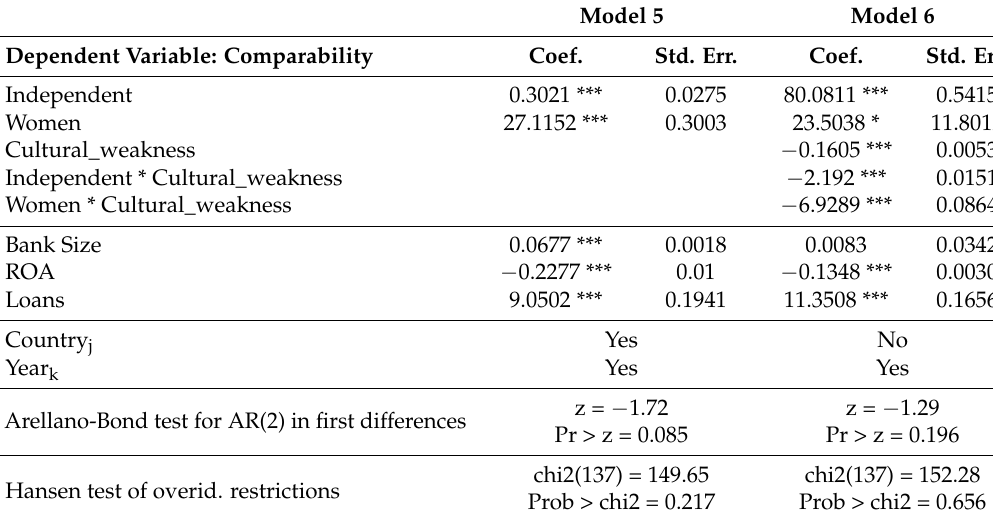
Table 8. Effect of independence and diversity of the board on